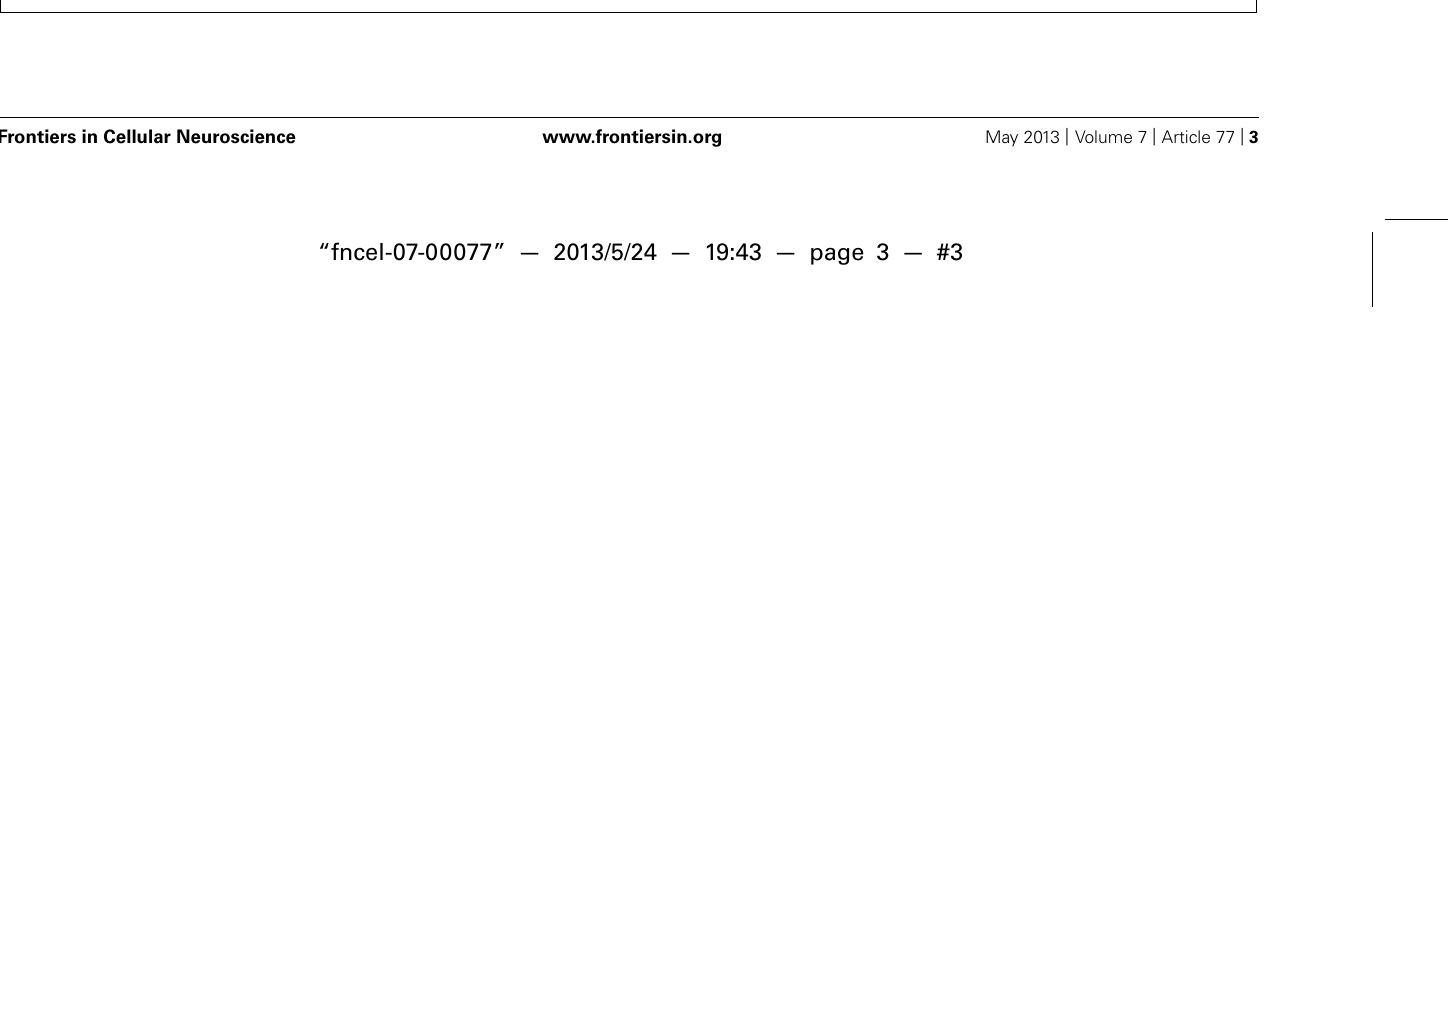
FIGURE 1 |Amyloid-beta protein precursor andA β are key regulators of synaptic activity. APP is processed by α -, β -, and/or γ -secretases to produce soluble N-terminal domains of APP (sAPP α and sAPP β ), A β and C-terminal fragments. A β increases LTD, inhibits LTP (Koffie etal., 2011), induces calcium-dependent synaptic vesicle depletion at the presynaptic membrane (Parodi etal., 2010), binds to numerous postsynaptic surface proteins including NMDAR (Danysz and Parsons, 2012), activates mGluR 5 signaling (Casley etal., 2009; Renner etal., 2010), induces Arc and APP expression (Lacor etal., 2004;Westmark etal., 2011b) and interferes with normal NMDAR and 2-amino-3-(3-hydroxy-5-methyl-isoxazol-4-yl)propanoic acid receptor (AMPAR) trafficking by triggering receptor internalization (Hsieh etal., 2006; Ma and Klann, 2012). Group 1 mGluRs are anchored to NMDAR via a chain of scaffolding proteins including the long isoforms of Homer, Shank, and postsynaptic density protein 95 (PSD95). A β induces disassembly of Shank1 and Homer1b clusters (Roselli etal., 2009). Group 1 mGluRs are upstream of two pivotal signaling pathways, PI3 kinase/Akt/mTOR (mammalian target of rapamycin)/p70S6K and Ras/MAPK (mitogen-activated protein kinase)/p90S6K. Both of these pathways regulate the phosphorylation status of eIF4E, 4E-BPs, and ribosomal protein S6, which positively influence protein synthesis. A β and sAPP activate MAPK ERK (Young etal., 2009; Chasseigneaux etal., 2011). A β both inhibits and activates mTOR signaling (Ma etal., 2010; Caccamo etal., 2011), and activates GSK3 β (Takashima etal., 1996), a key regulator of numerous signaling pathways. APP, sAPP, and the intracellular C-terminal fragments also affect synaptic homeostasis. APP anchors cytoplasmic polyadenylation element binding factor (CPEB) to membranes and promotes polyadenylation-induced translation (Cao etal., 2005). sAPP α increases de novo protein synthesis (Claasen etal., 2009), enhances LTP (Taylor etal., 2008), shifts the frequency-dependency